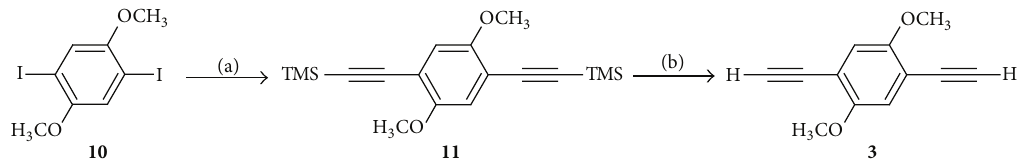
Scheme 3: Synthesis of polymer repeat 3 . Reaction conditions: (a) palladium catalyst, CuI, Et 3 N, toluene, and TMS acetylene; (b) THF, NaOH, and